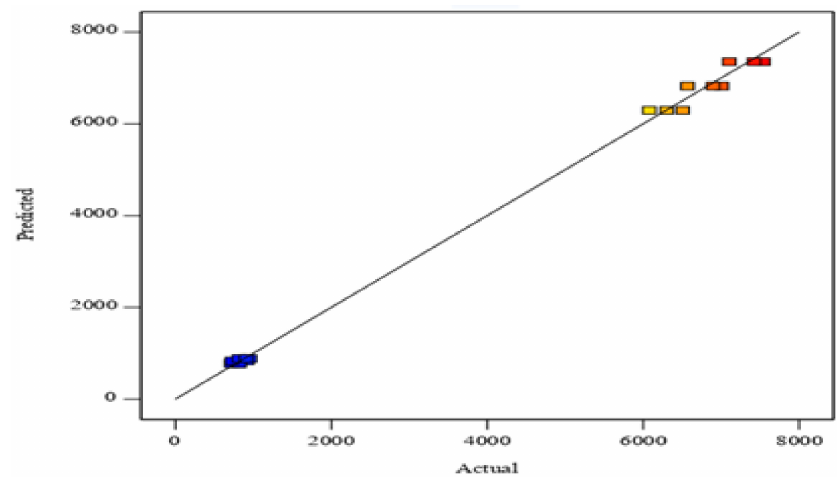
Figure 9. Plot of actual versus predicted values of the 2FI model.